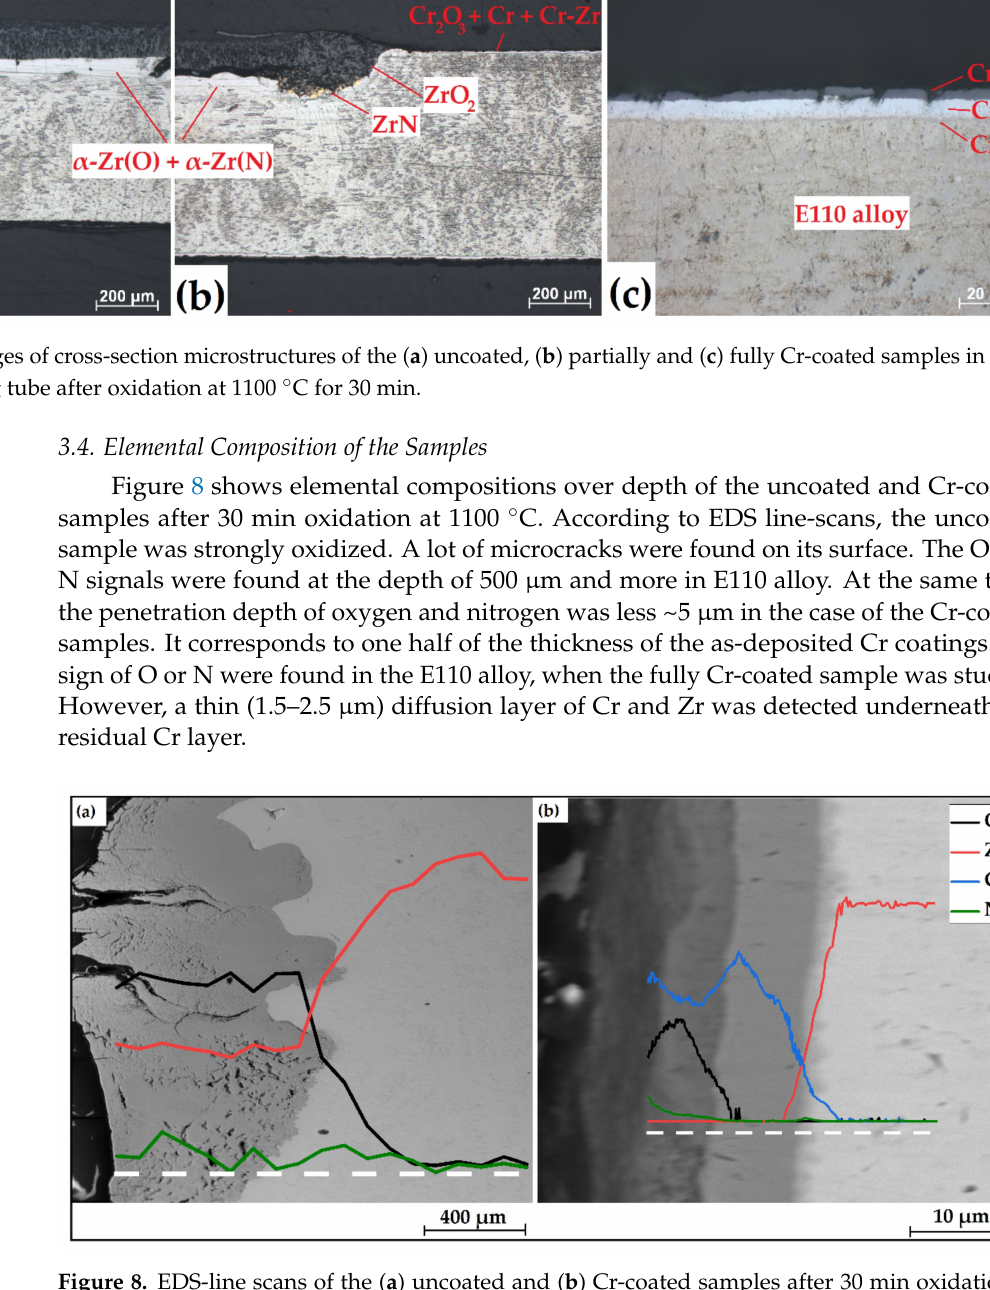
Figure 8. EDS-line scans of the ( a ) uncoated and ( b ) Cr-coated samples after 30 min oxidation at 1100 ◦ C. White dashed lines indicate the measurement